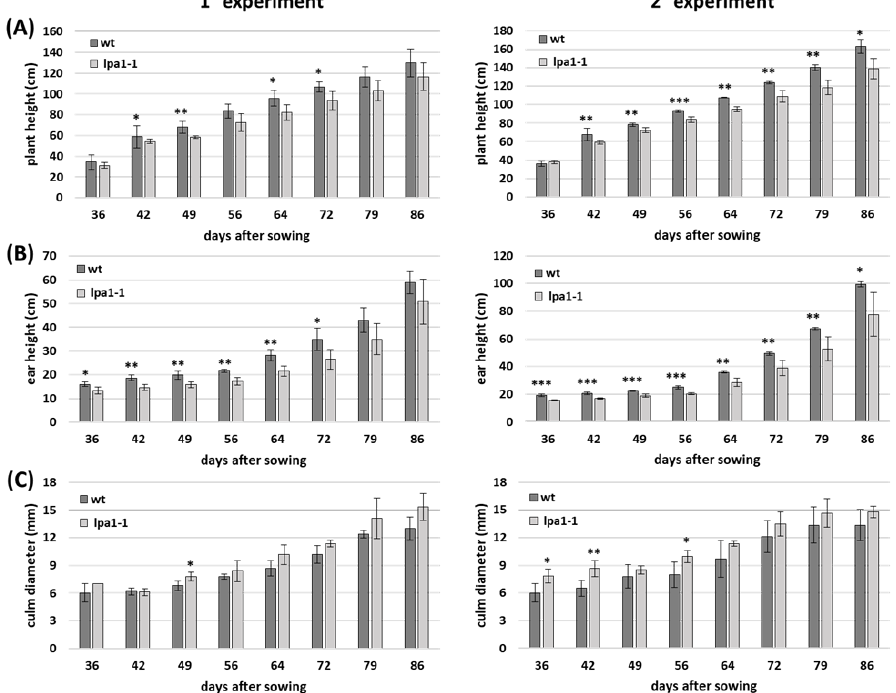
Figure 6. Depth of the embryonic primary root ( A ) and of the post-embryonic crown roots ( B ) measured every week till flowering. The data represent the means of three biological replicates in two different experiments. Significant differences between wild-type and lpa1-1 were assessed by Student’s t -test (** p < 0.05).